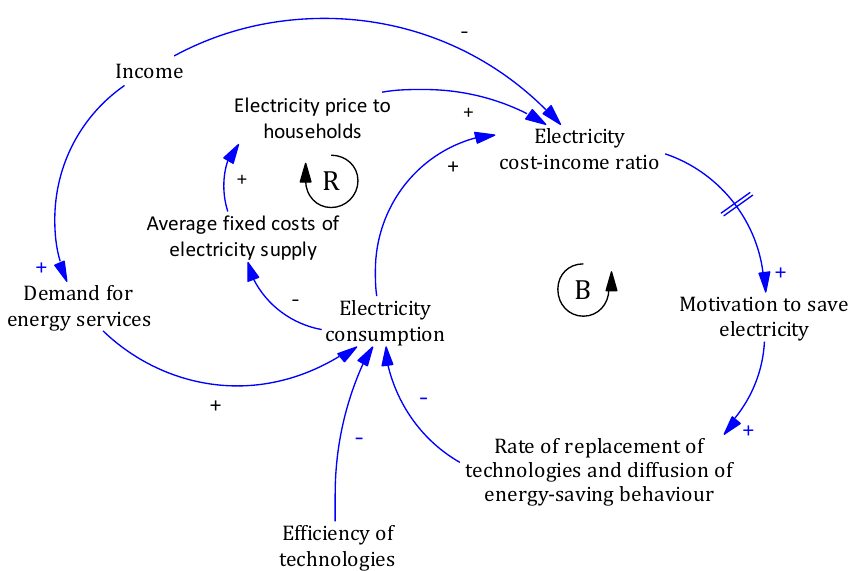
Fig. 1. Dynamic hypothesis – a causal loop diagram (CLD) illustrating the main feedback